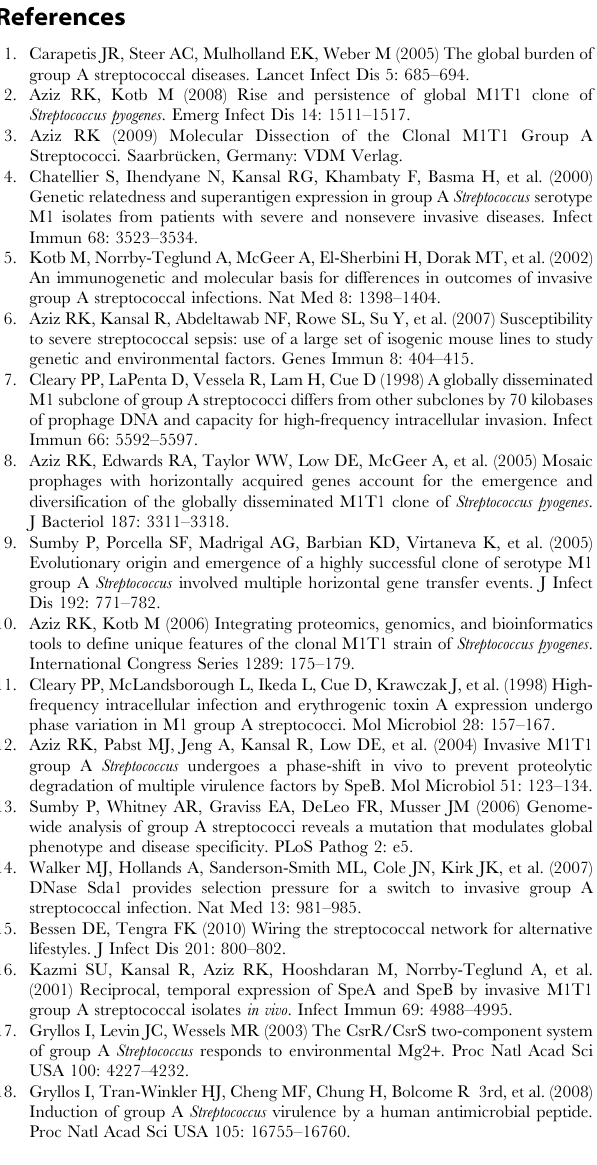
Table S2 Gene lists reflecting significant (P , 0.05) differential expression ratios between each pair of